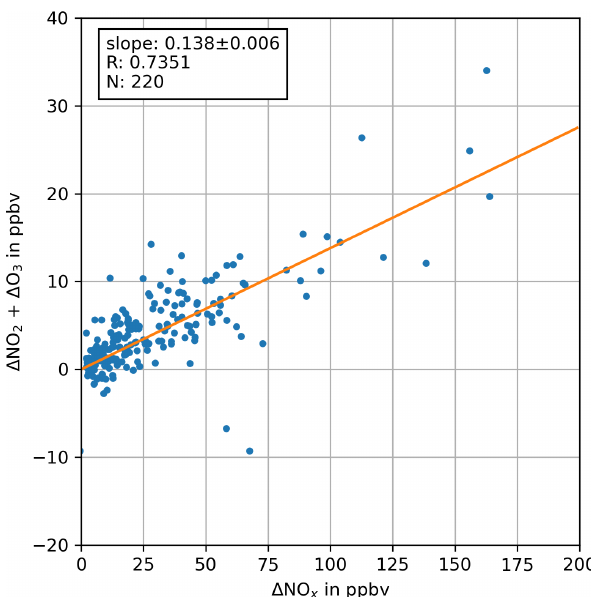
Figure 4. Plot of (cid:49) NO 2 + (cid:49) O 3 against (cid:49) NO x from peaks measured with the in situ instruments between April 2018 and May 2019. All concentrations have been corrected for background concentrations. For this analysis, 220 manually quality-checked peaks were used. This results in a slope (a NO 2 / NO x ratio) of 0.138 with a respective standard error of